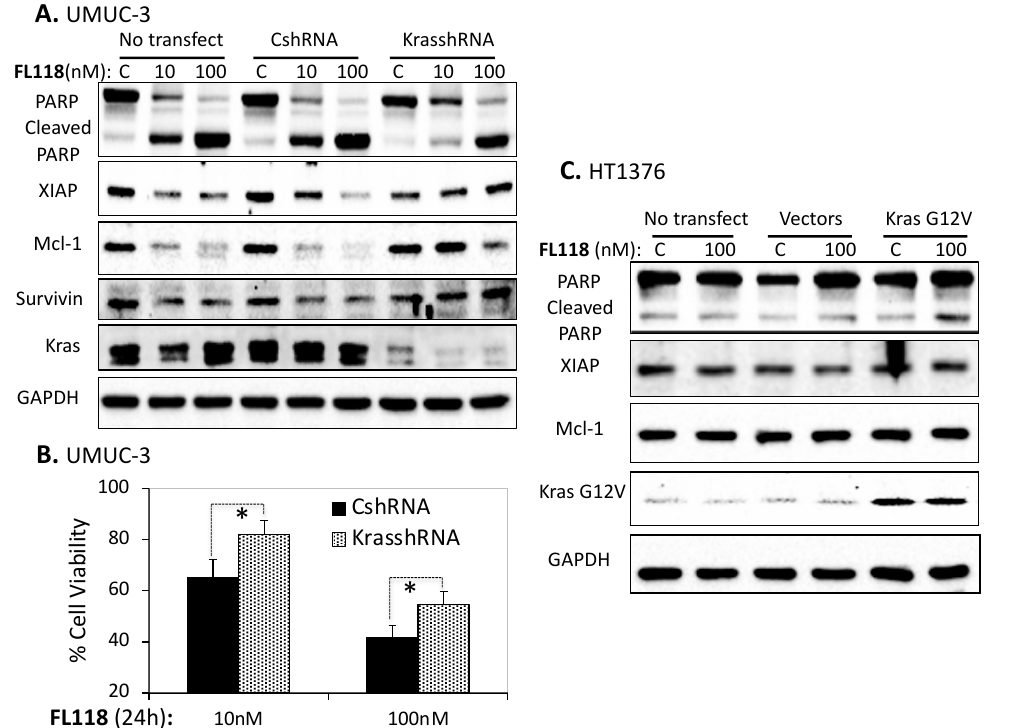
Figure 6. Role of mutant Kras in FL118-mediated apoptosis and inhibition of anti-apoptotic protein expression and cell viability. ( A ) Silencing of Kras G12C via Kras-specific shRNA in UMUC-3 cells increases cell resistance to FL118-induced apoptosis (less PARP cleavage). UMUC-3 cells were infected with Kras-specific lentiviral shRNA identified in our previous studies [21] or control shRNA followed by treatment with DMSO or FL118 (10 and 100 nM) for 24 h. At the end of treatment, Western blot analysis was performed to check PARP cleavage and the expression of anti-apoptotic proteins (XIAP, Mcl-1, survivin). GAPDH was used as an internal control. ( B ) 3-(4,5-dimethylthiazol-2-yl)-2,5- diphenyltetrazolium bromide (MTT) assay was performed to determine cell viability with 10 nM and 100 nM FL118 treatment in UMUC-3 cells infected with control scramble shRNA and Kras-specific shRNA. Each bar in the histogram data is the mean ± SD from three independent assays. ( C ) E ff ect of forced expression of Kras G12V in HT1376 cells. HT1376 cells were transfected with Kras G12V or control vectors followed by treatment with DMSO or 100 nM FL118 for 48 h. At the end of treatment, Western blot analysis was performed to check the expression of apoptosis-related proteins. GAPDH was used as an internal control of total protein-loading. * p -value <